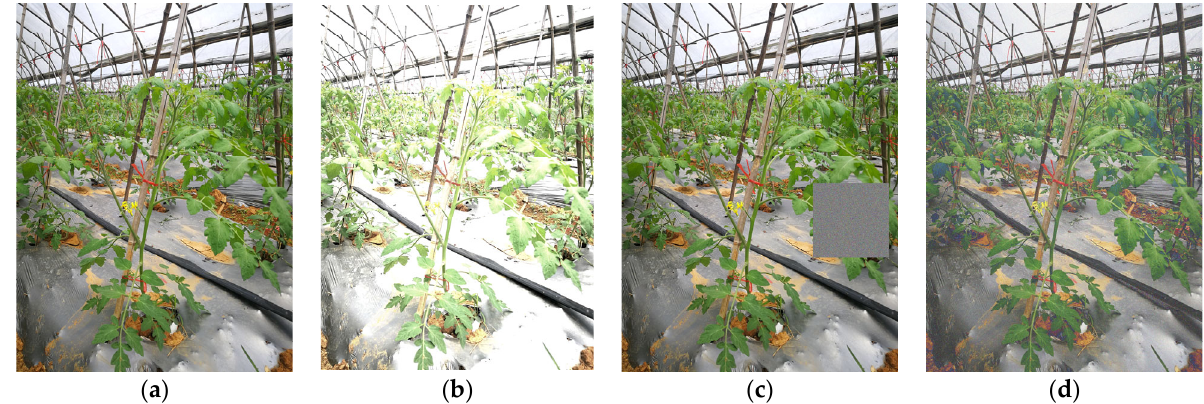
Figure 2. Some examples of different data augmentation methods. ( a ) Original; ( b ) random bright- ness changes; ( c ) random erase; ( d ) Gaussian noise.